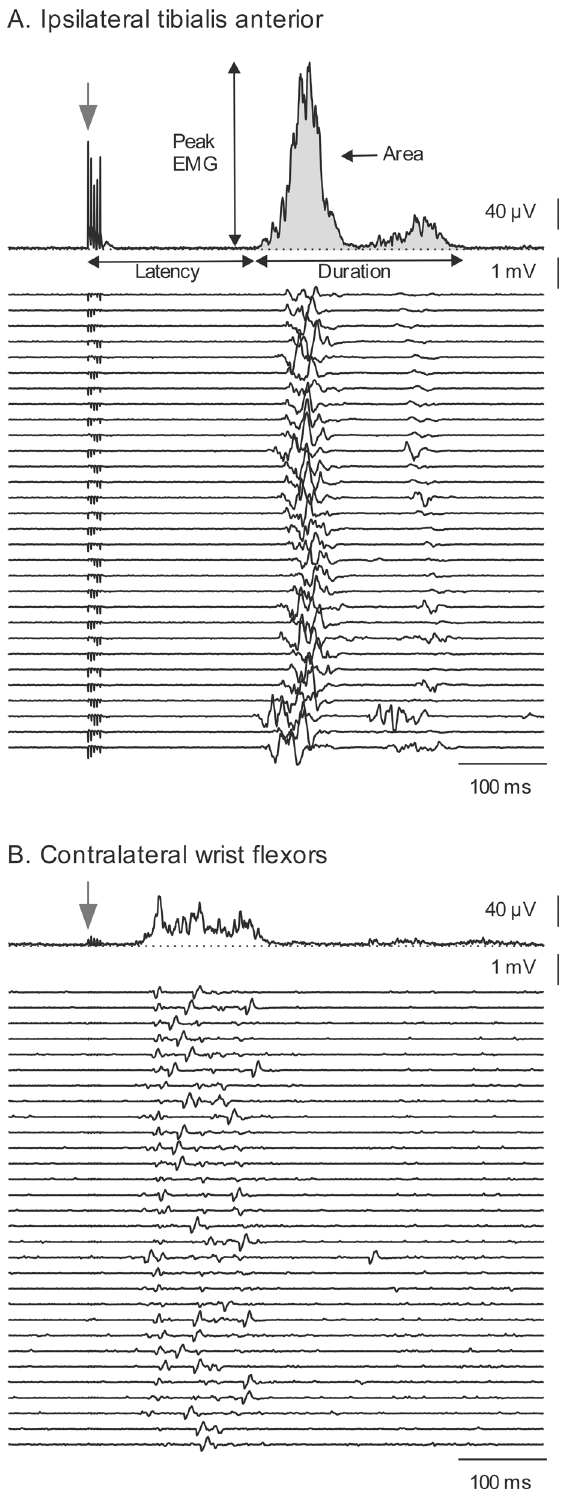
Fig 1. A within-limb and an interlimb reflex evoked in a participant with SCI. EMG was evoked in (A) the ipsilateral tibialis anterior and (B) contralateral wrist flexors with superficial peroneal nerve stimulation (within- limb and interlimb reflex respectively). The top trace in each panel depicts the rectified averaged EMG from